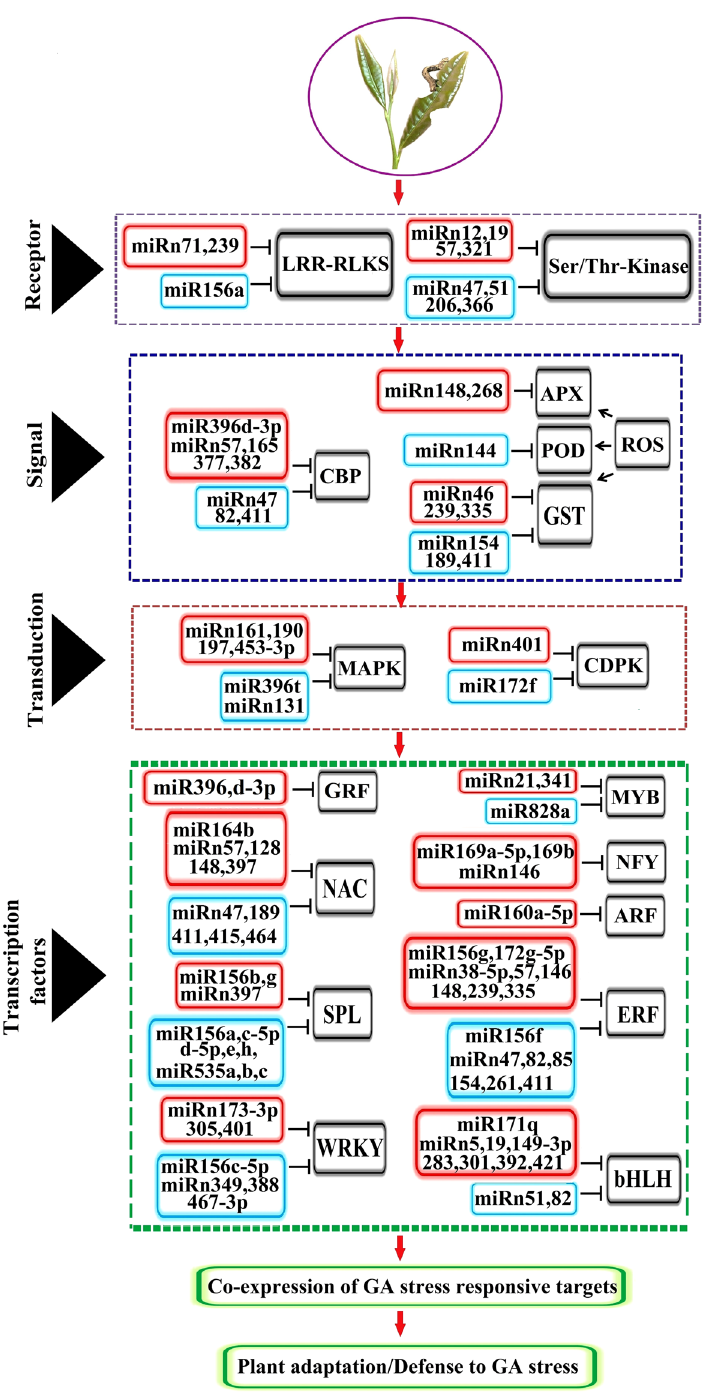
Figure 5. A hypothetical model of GA-responsive miRNA regulatory networks in tea plant. Leucine-rich repeat receptor-like protein kinases (LRR-RLKs), Serine/threonine-protein kinase (Ser/Thr_kinase), Calcium-binding protein (CBP), Reactive oxygen species (ROS), L-ascorbate peroxidase (APX), Peroxidase (POD), Glutathione- S-transferase (GST), Mitogen-activated protein kinase (MAPK), Calcium-binding protein, calcium-dependent protein kinase (CDPK), MYB domain proteins (MYBs), NAC domain transcription factors (NACs), Squamosa promoter-binding-like protein (SPLs), WRKY transcription factor (WRKYs), Nuclear transcription factor Y (NFYs), Auxin response factors (ARFs), Ethylene-responsive transcription factors (ERFs), Basic helix-loop- helix proteins (bHLHs), Growth-regulating factor (GRF). Up- and down-regulated csn-miRNAs are indicated in red and blue boxes respectively. All predicted target genes are represented in black